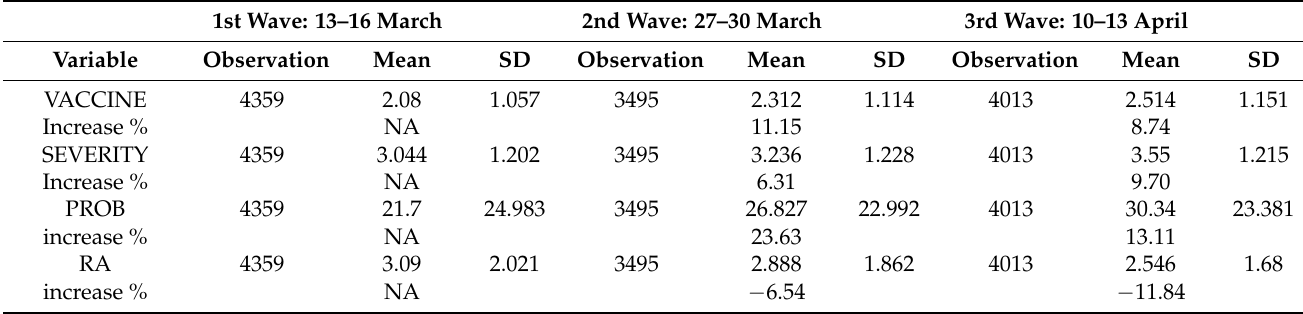
Table 3. Descriptive statistics of the variables used in this paper: each